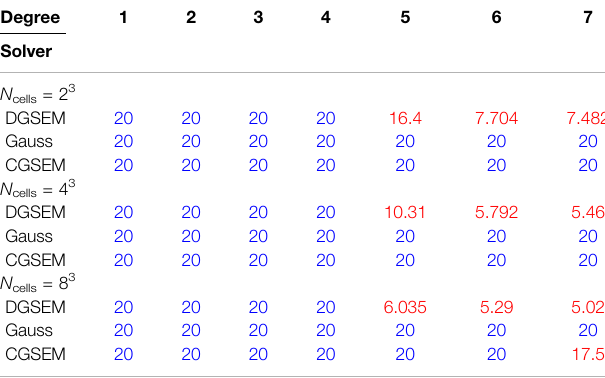
TABLE 6 | End time for entropy conservative simulations of the Taylor-Green vortex on hexahedral meshes.